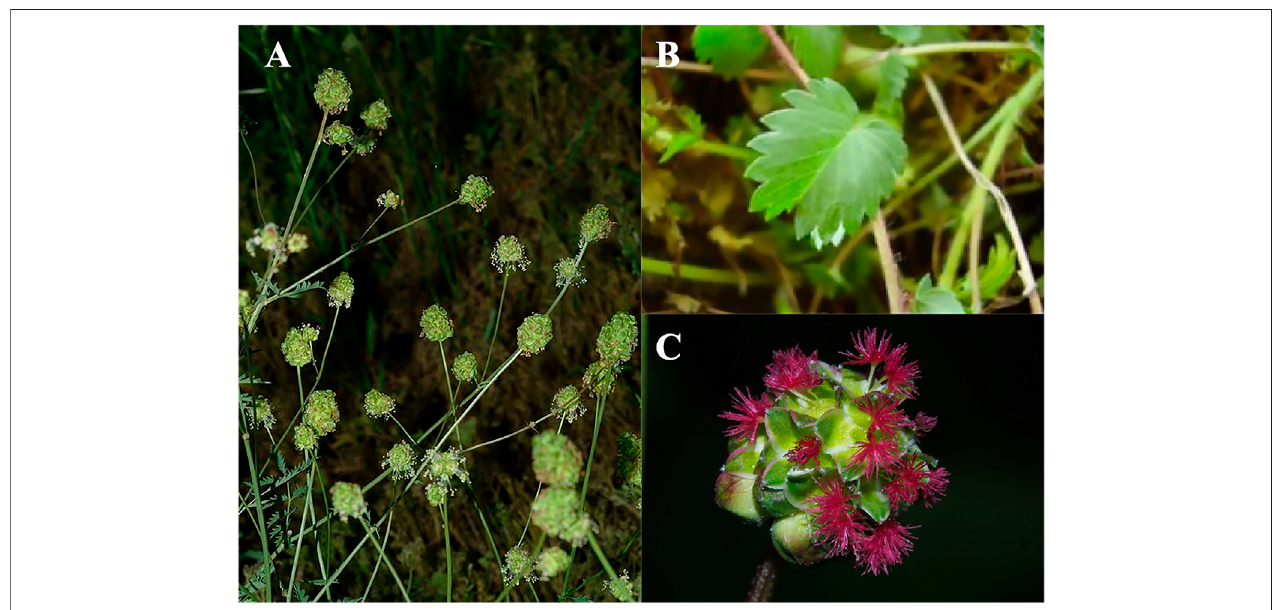
FIGURE4| Sanguisorbaminor Scop.Plants(KewBotanicalGarden,2021b).Thewholeplantof S.minor (A) ;theleavesof S.minor (B) ;the fl owersof S.minor (C) .